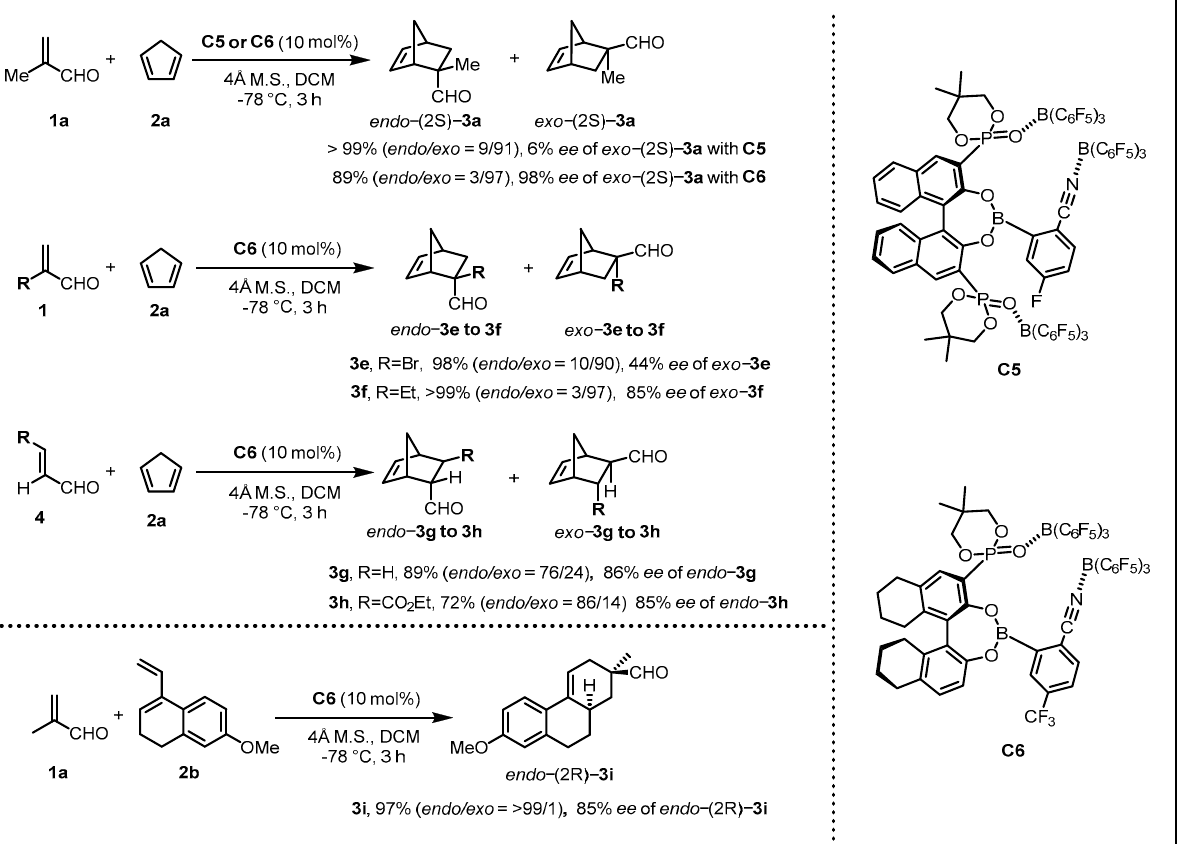
Figure 3. Reactions of various acroleins with cyclopenta-1,3-diene.